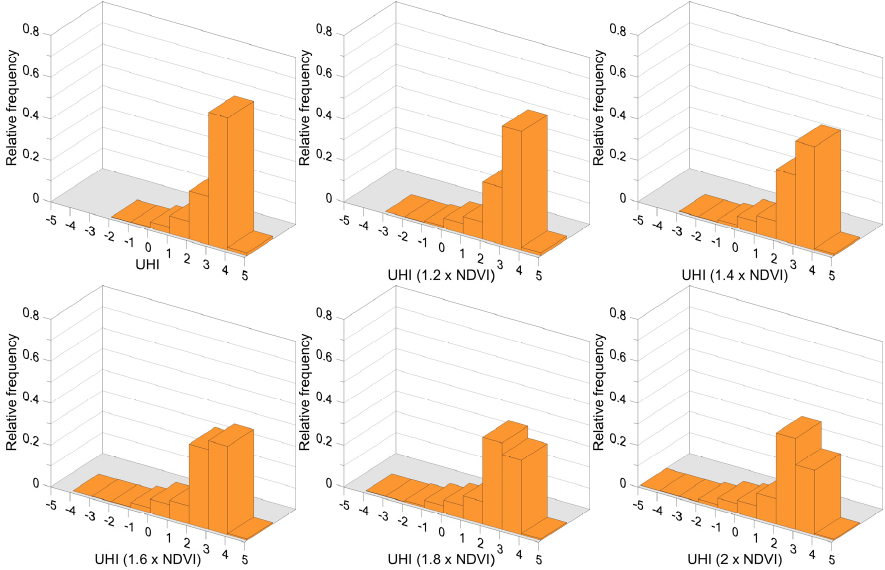
Figure 10. Relative frequency of simulated UHI classes.